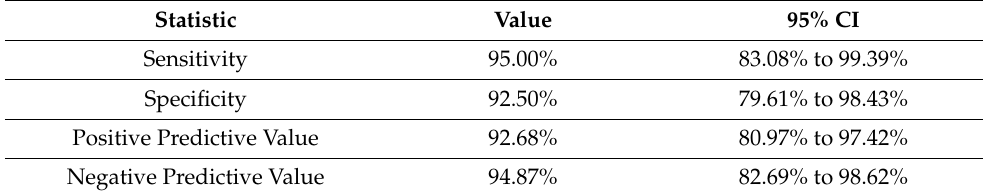
Table 5. Sensitivity and specificity of Gal-3.